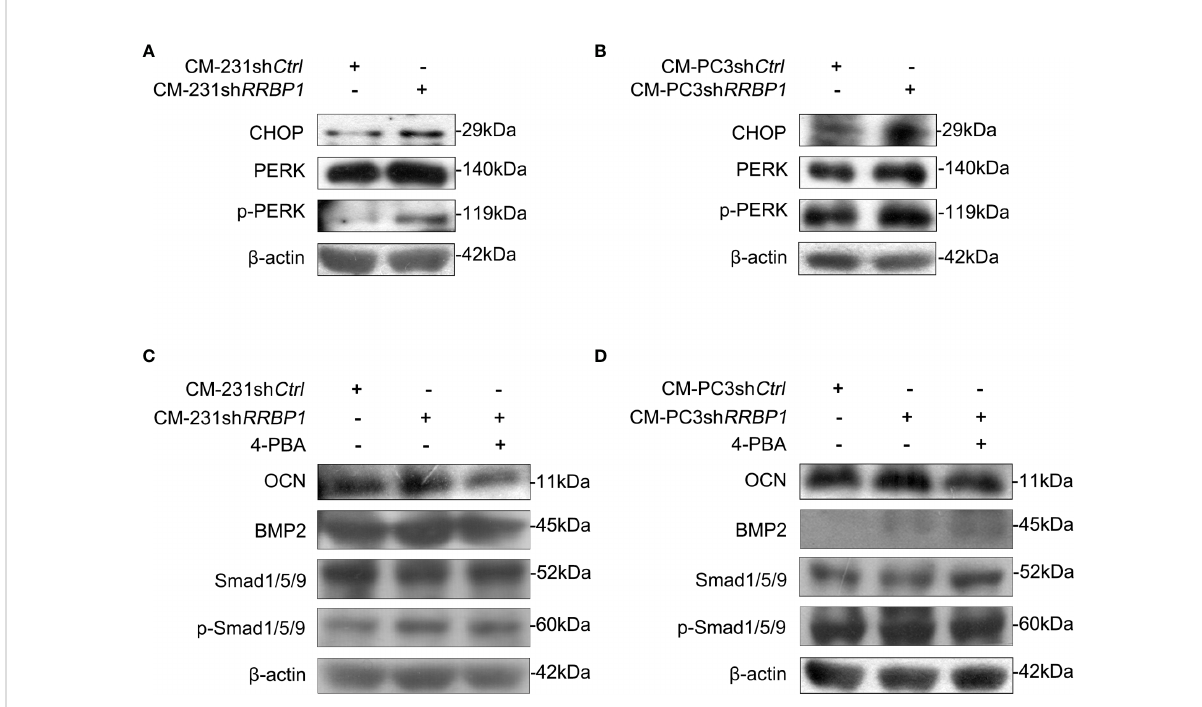
FIGURE 4 The involvement of ER stress in increased expression of osteoblastic phenotype mediated by CM from MDA-MB-231 or PC3 cells transduced with sh RRBP1 . (A, B) MC3T3-E1 cells were cultured in a -MEM+CM-231sh Ctrl and a -MEM+CM-231sh RRBP1 or a -MEM+CM-PC3sh Ctrl and a - MEM+CM-PC3sh RRBP1 for 7 d, respectively. The protein levels of CHOP, PERK, p-PERK, and b -actin were measured via western blotting analysis. (C, D) MC3T3-E1 cells were cultured in a -MEM+CM-231sh Ctrl and a -MEM+CM-231sh RRBP1 or a -MEM+CM-PC3sh Ctrl and a -MEM +CM-PC3sh RRBP1 for 5 d, followed by the treatment of 4-PBA (0.5 mM) for 2 d. The protein levels of OCN, BMP2, Smad1/5/9, p-Smad1/5/9, and b -actin were measured via western blotting analysis. The data are representative of three independent